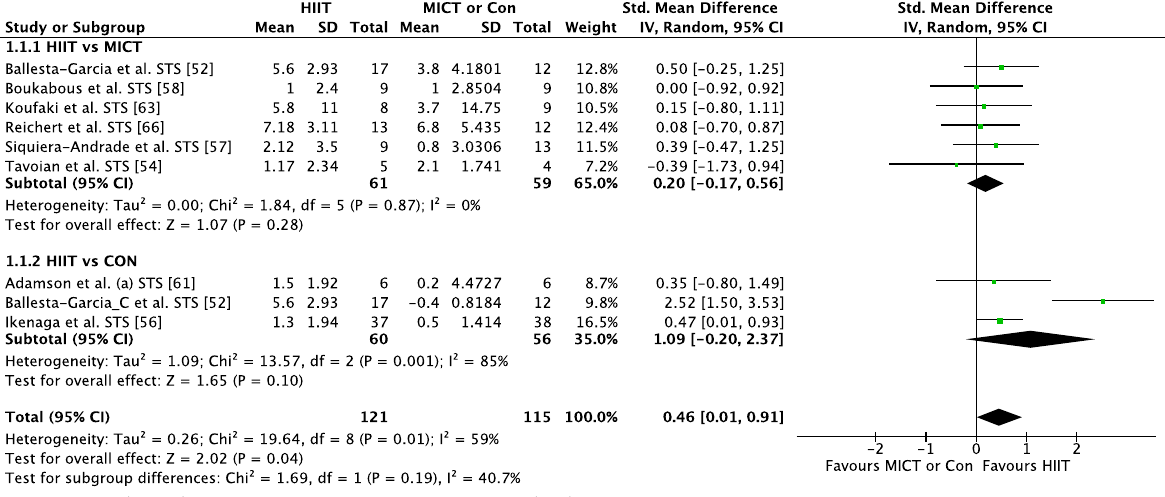
Fig. 6 Meta-analysis subgroups HIIT versus MICT, HIIT versus Control with STS outcome